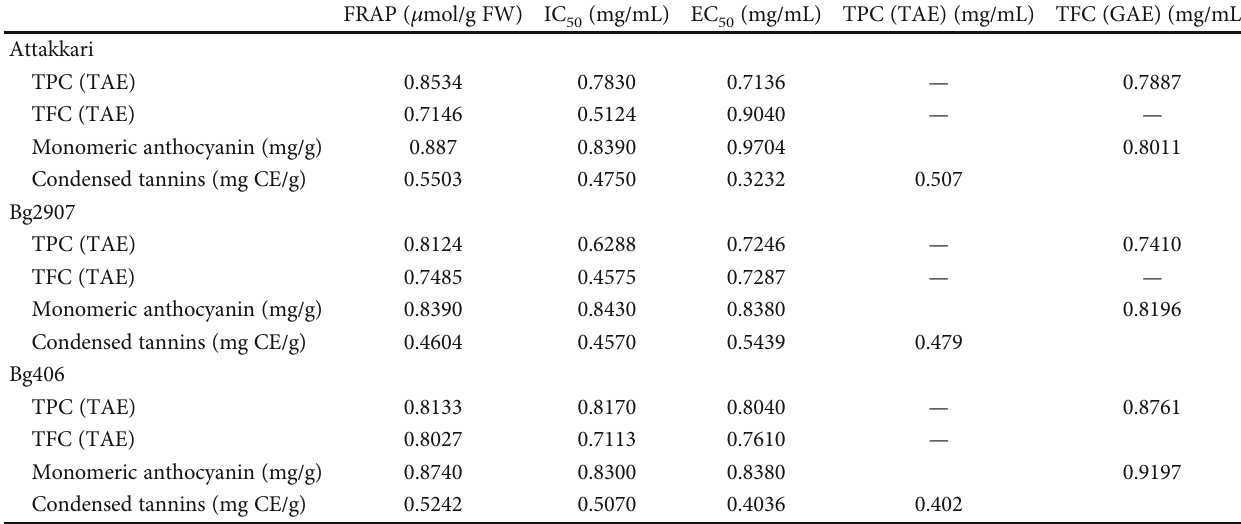
Table 4: Correlation ( r 2 ) values among the antioxidant capacity measures of di ff erent